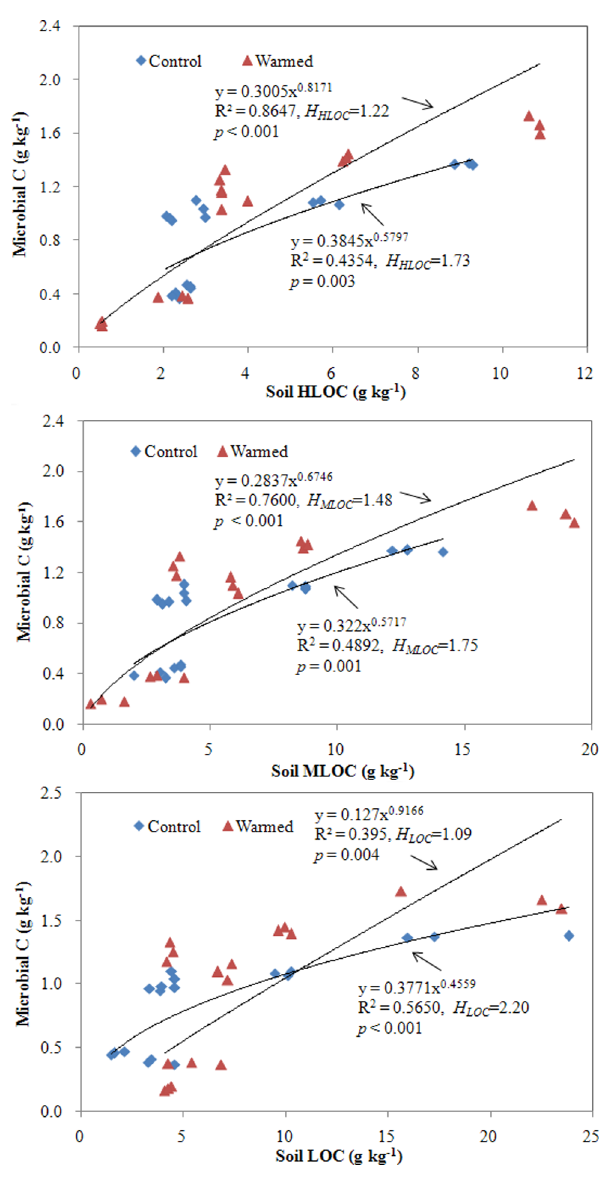
Figure 1. Relationships between soil microbial carbon (MB-C) and soil organic carbon (in forms of HLOC: highly labile organic carbon, MLOC: mid-labile organic carbon, and LOC: labile organic carbon). Control and Warmed represent treatments of ambient temperature and ambient temperature + 5 u C, respectively. Sampling date is March 2011. Coefficients fitting the data to the equation for stoichiometric homeostasis are given along with an estimate of H C